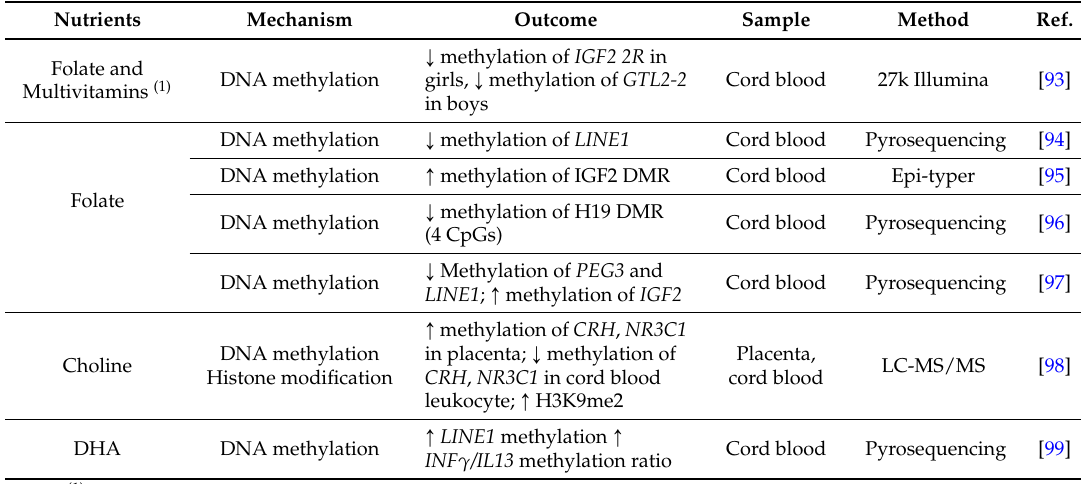
Table 2. Intervention studies for maternal nutritional status and epigenetic profile in